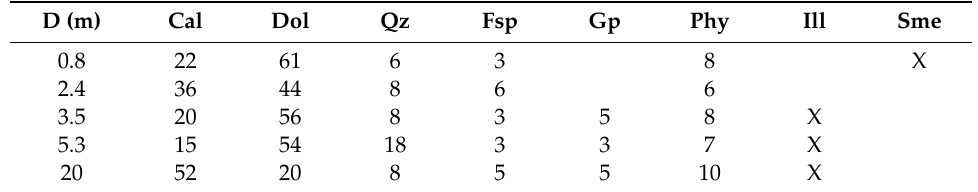
Table 3. XRD analysis of the samples from the central segment of the Baza Fault at the Barranco del Agua gully (west section). The distance corresponds to the distance from fault, which is also plotted on the x-axes of the plots in Figure